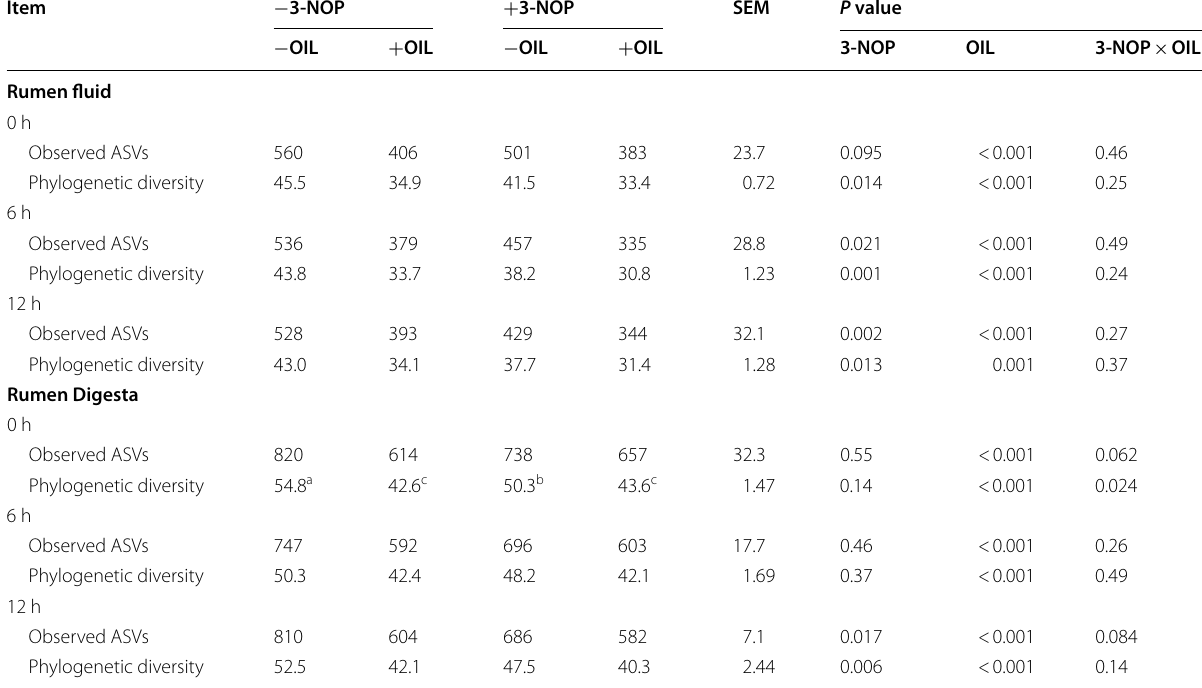
OIL, canola oil; 3-NOP, 3-nitrooxypropanol a,b,c Values within a row with different letters differ ( P